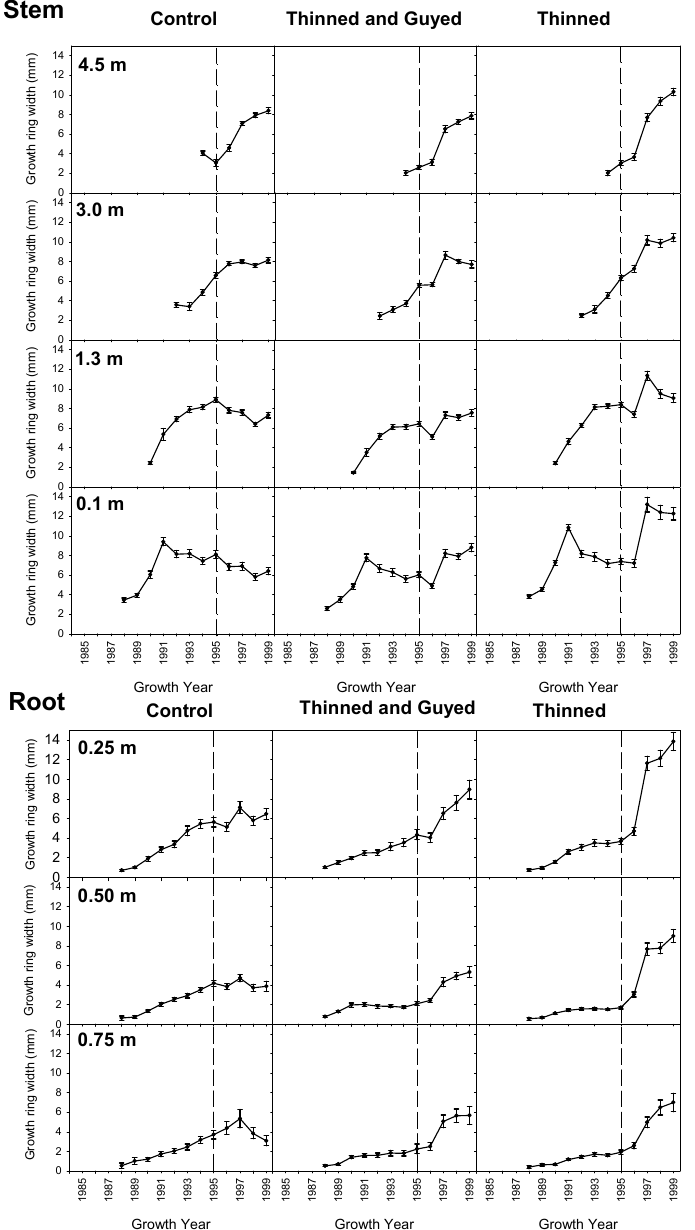
Figure 5. Mean ( ± standard error) radial growth in the stem (0.1 m, 1.3 m, 3.0 m and 4.5 m) in each of the treatments between the 1990 and 1999 growth years. Radial growth in structural roots from one plot (at 0.25 m, 0.50 m and 0.75 m from the tree centre) are shown for comparison. The dashed vertical lines mark the last growth year before treatment.